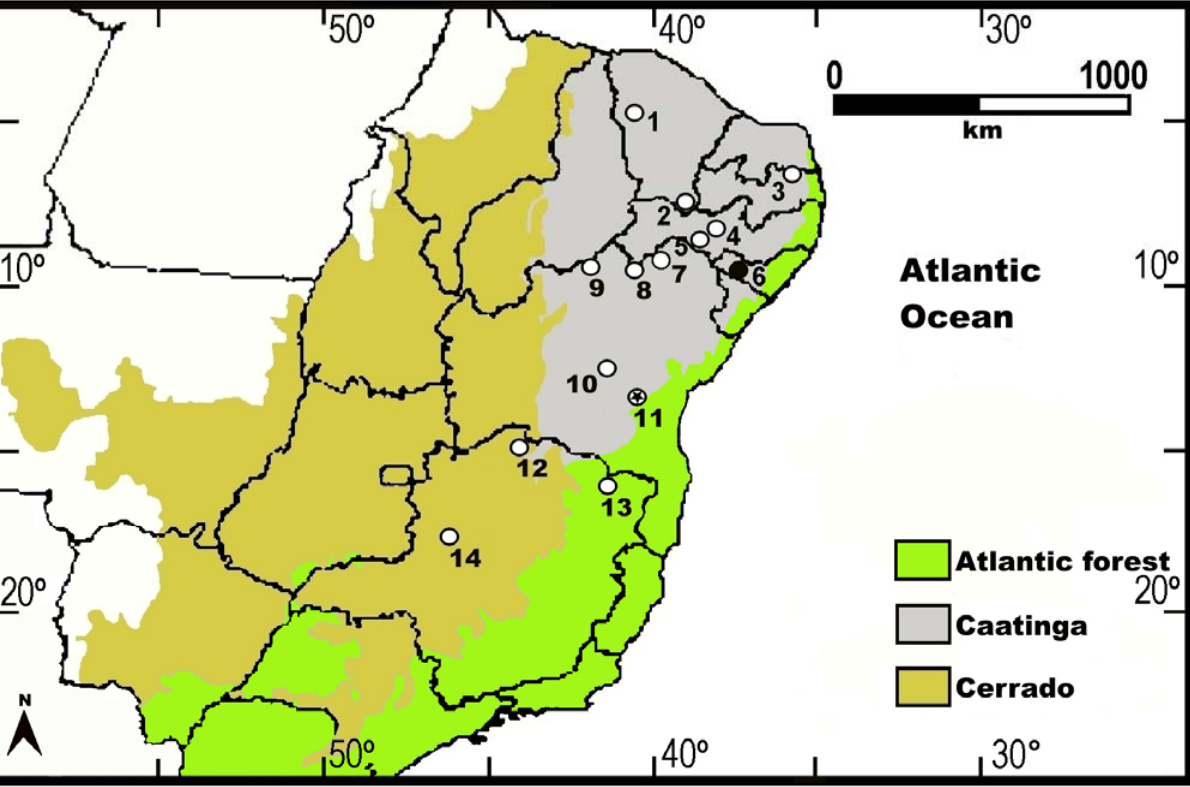
Figure 2. Physalaemus cicada distribution map. New record (black circle) – state of Alagoas (AL): São José da Tapera (6). Literature records (star and white circles) – state of Ceará (CE): Nova Russas (1) (Loebmann and Mai 2008), Brejo Santo (2) (Nascimento et al. 2005); state of Paraíba (PB): Araruna (3) (Arzabe et al. 2005); state of Pernambuco (PE): Betânia (4) (Borges-Nojosa and Santos 2005), Floresta (5) (Borges-Nojosa and Santos 2005); state of Bahia (BA): Curaçá (7) (Nascimento et al. 2005), Juazeiro (8) (Nascimento et al. 2005), Carnaíba (9) 2005), João Pinheiro (14) (Silveira